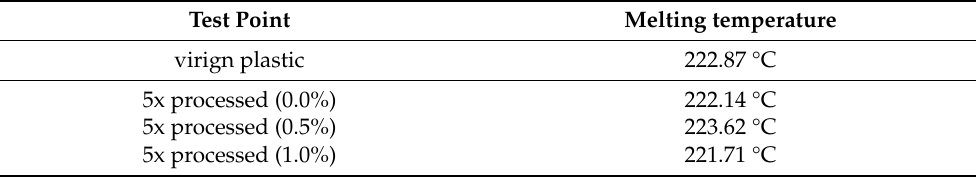
Table 1. Measured melting